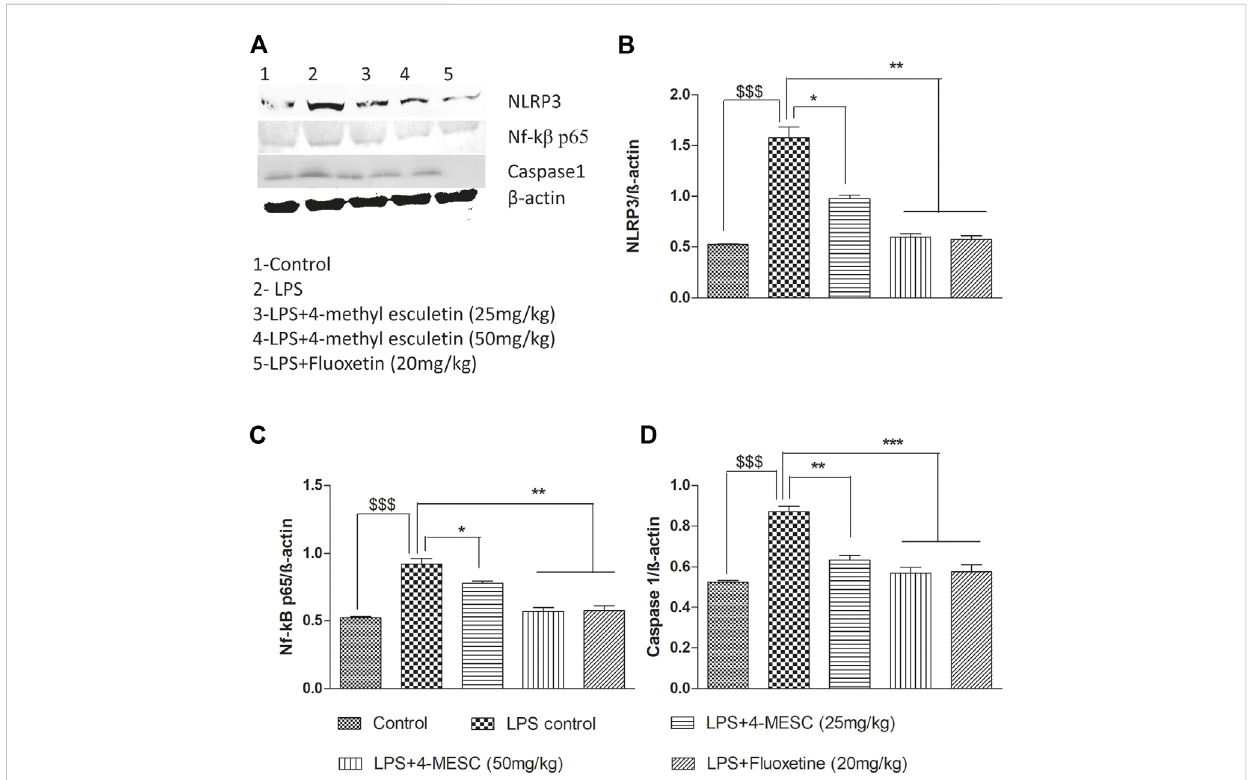
FIGURE 8 Effect of4-MESCon expression involvedintheNLRP3in fl ammasome pathway evaluated usingwesternblot. (A) Representative western blotimage of different proteins, where lane 1, 2, 3, 4, and 5 represent the control, LPS, LPS +25 mg/kg of 4-MESC, LPS +50 mg/kg of MESC, and LPS+20 mg/kg of fl uoxetin group, respectively. (B) NLRP3, (C) caspase-1, (D) Nf- κ B. b-actin was taken as the loading control.